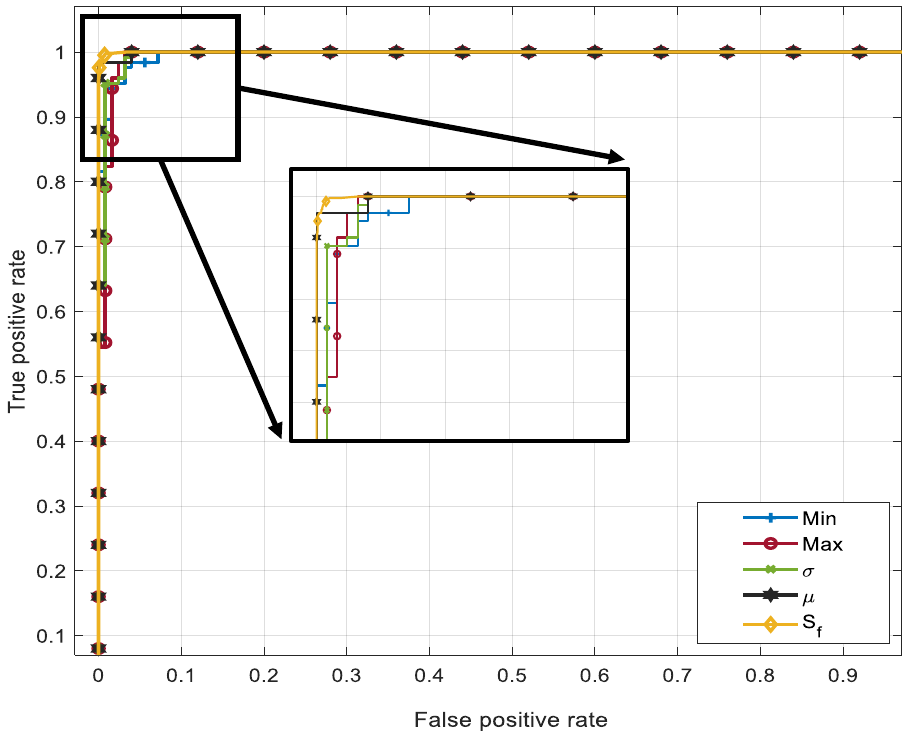
Figure 5. ROC curves of four sub-classifiers depicting S i ( µ ) , S i ( σ ) , S i ( max ) , and S i ( min ) scores compared to the accuracy of the proposed score fusion S f